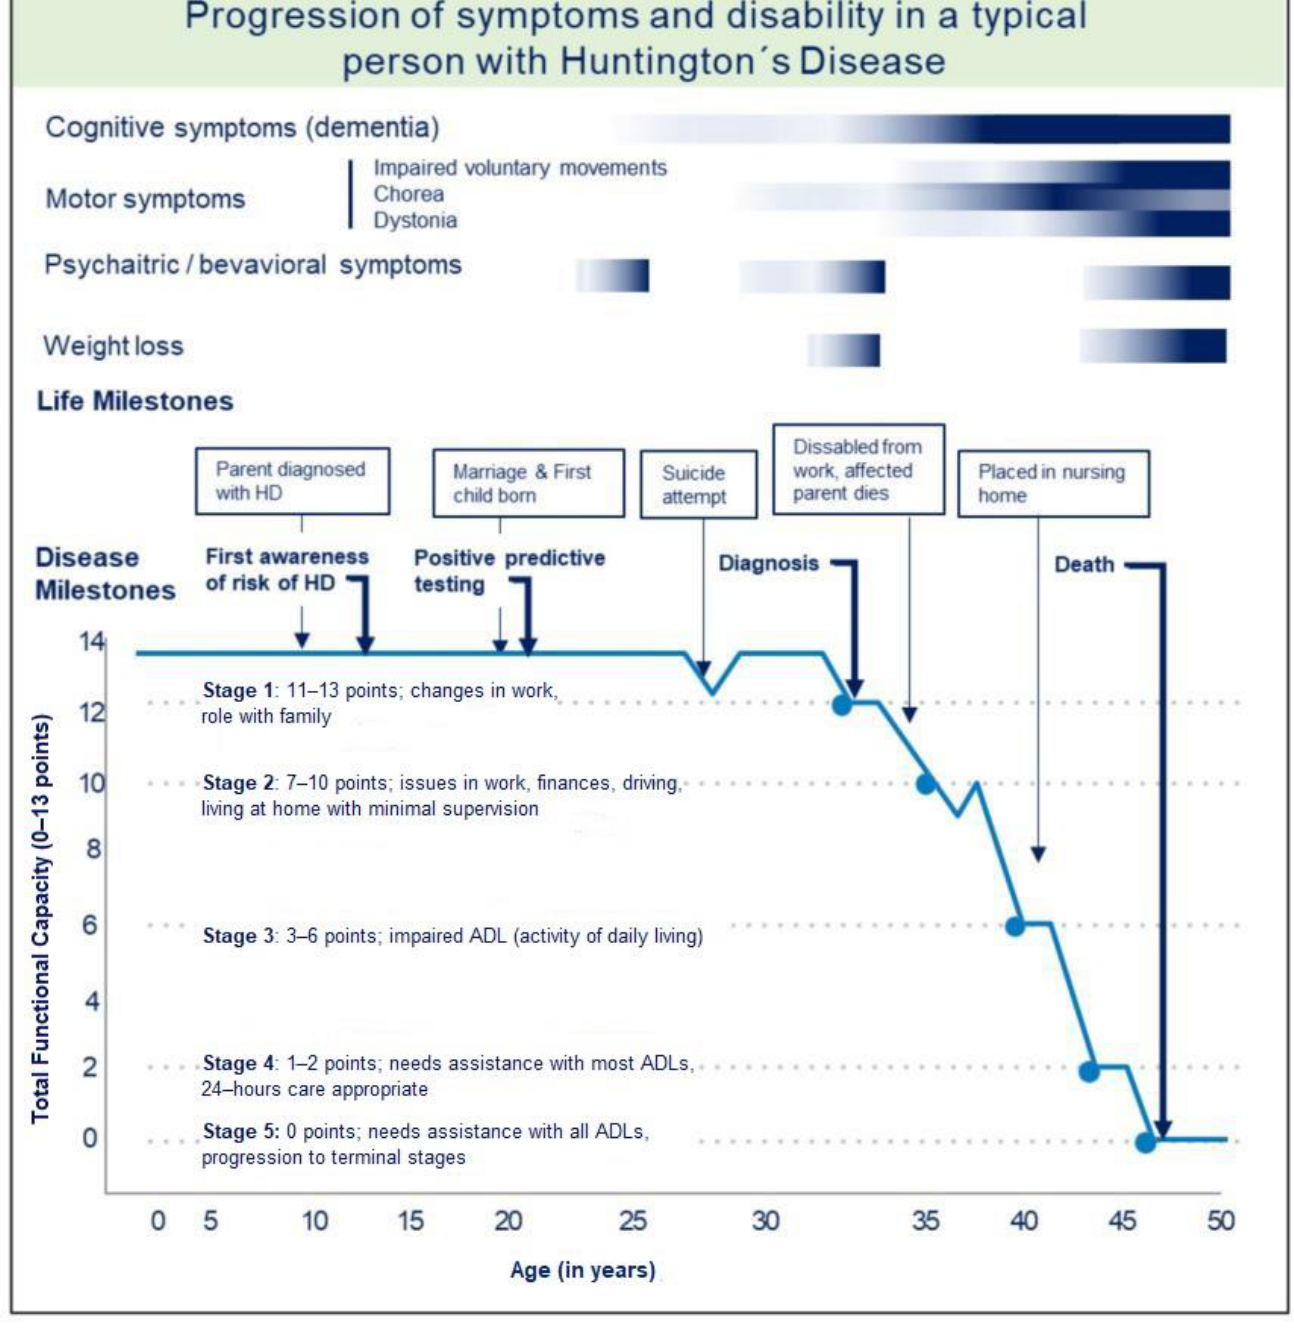
Figure 1. Progression of symptoms and disability in a typical person with HD, adapted from A Physician Guide to Management of HD [15] and onset of cognitive impairment adjusted by Langley et al., 2021 [16].